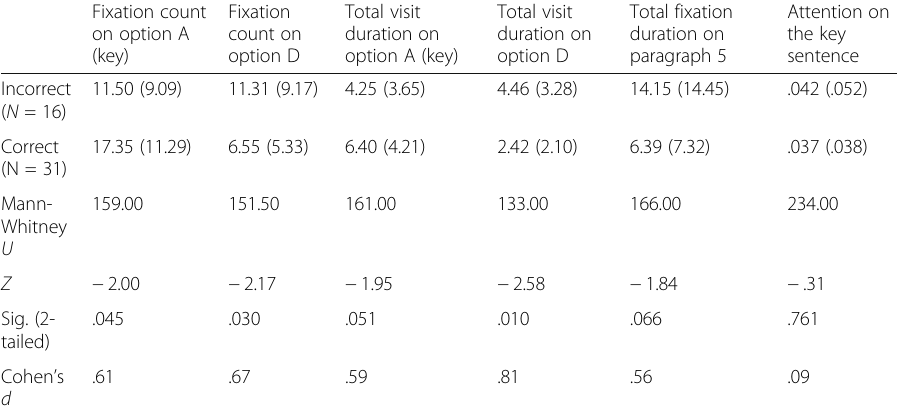
Table 10 Eye-tracking statistics for item